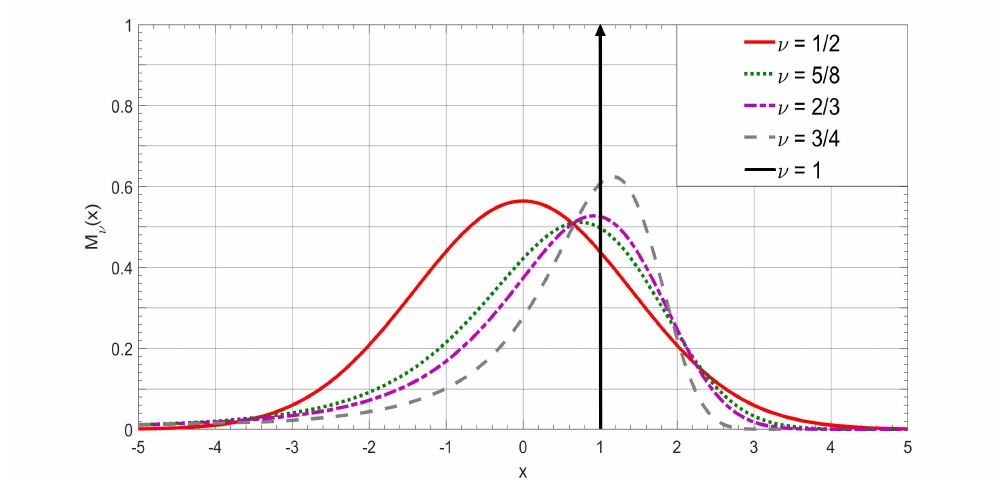
Figure 2. Plots of the M -Wright function as a function of the x variable, for 1/2 ≤ ν ≤